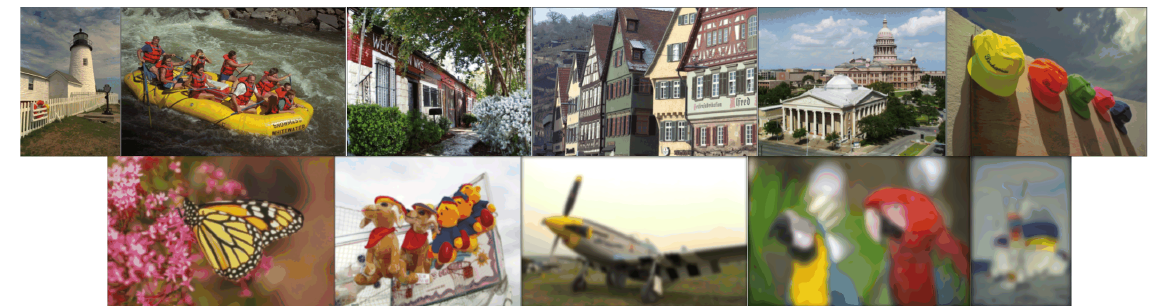
Figure 18. Content-independent images with increasing blur.